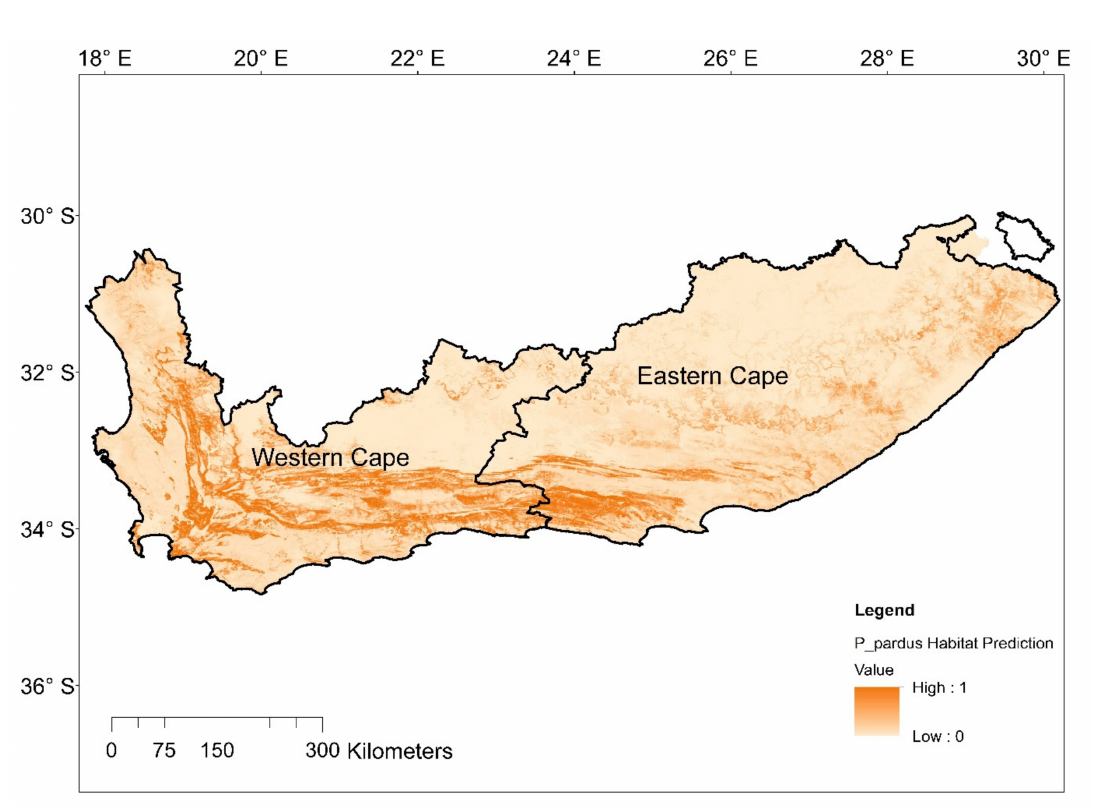
Figure 4. Predicted leopard habitat using the full model masked to the Eastern and Western Cape. Non-leopard habitat has value of 0 with predicted leopard habitat quality increasing to